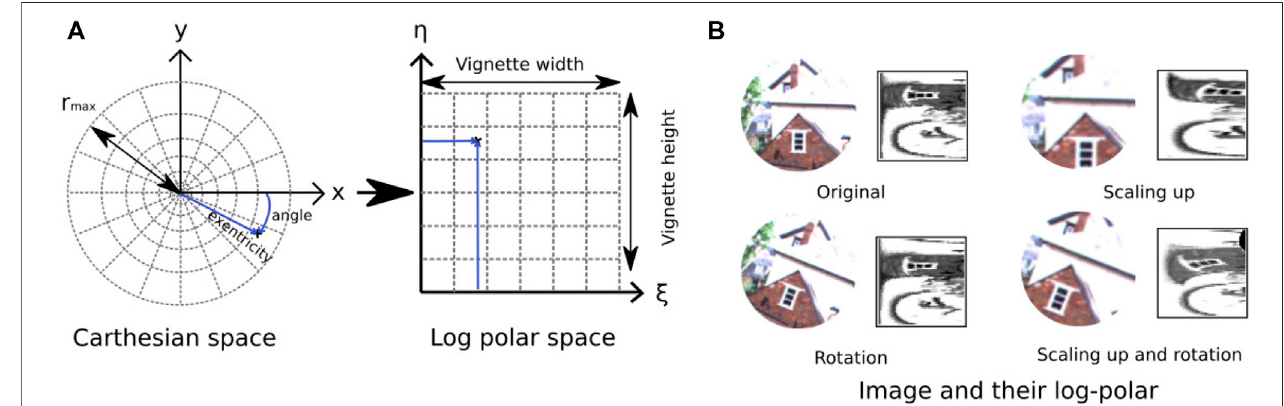
FIGURE4| Illustrationoflog-polartransform. (A) Log-polartransformationconvertsacircularvignetteofsize r max fromthe2DCartesiancoordinatesystemintothe log-polarcoordinate system with ξ (eccentricity) and η (angle). (B) Examplesoflog-polar code forthree transformations (rotation, scaling up, and rotation combined with scaling up). Left , input image; right , log-polar